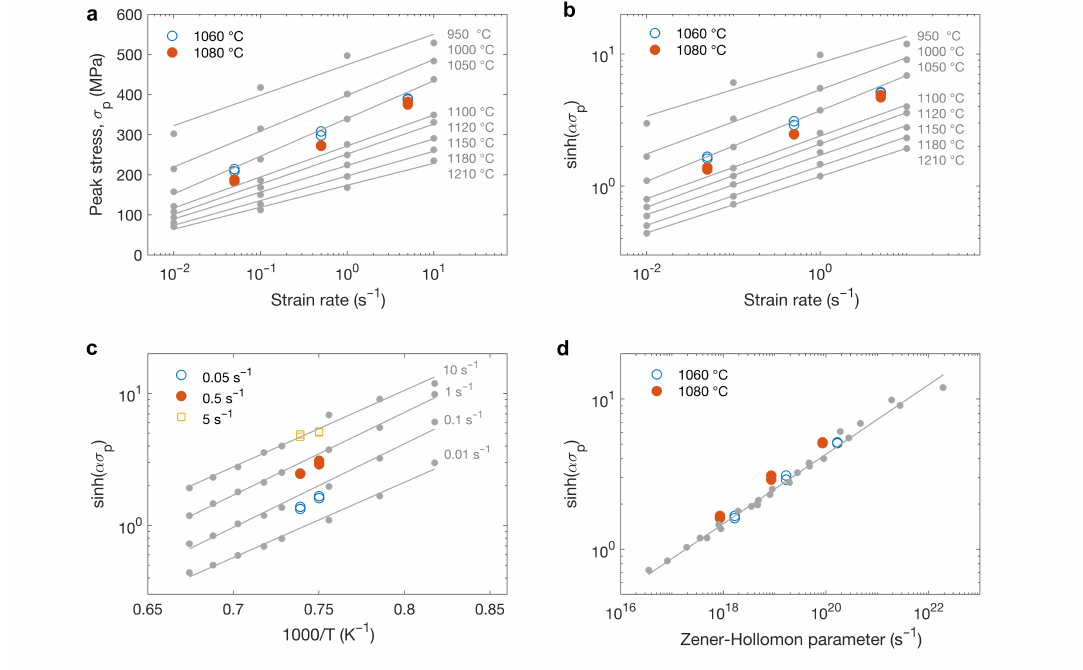
Figure 5. Comparison of current results with data from Shi et al. [24]. In all cases, gray solid points are data from Shi et al. and gray lines are linear fits as obtained in [24]. ( a ) Peak stress σ p as a function of temperature, ( b ) sinh [ ασ p ] as a function of strain rate. ( c ) sinh [ ασ p ] as a function of inverse temperature. ( d ) sinh [ ασ p ] as a function of Zener-Hollomon parameter Z (obtained using Q = 498 kJ mol − 1